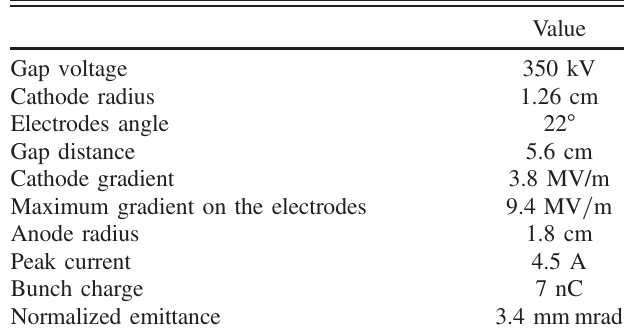
TABLE I. dc gun design